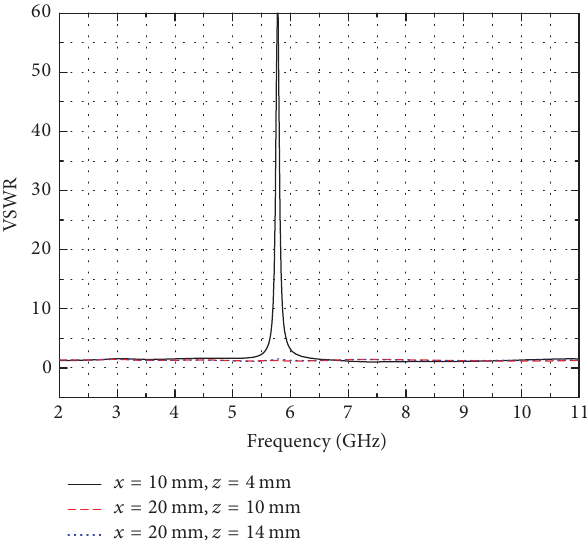
Figure 6: Comparison of simulated VSWR results depending on positions of the split loop.